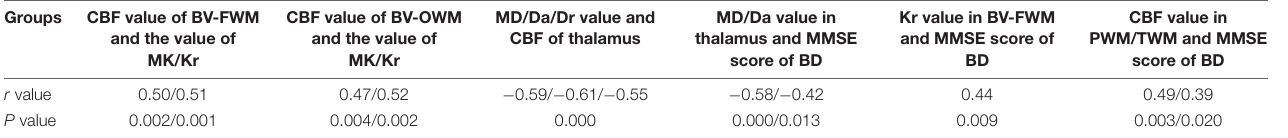
TABLE 3 | Correlations among DKI-derived parameters, ASL-derived parameters, and MMSE score obtained from patients with BD. Groups